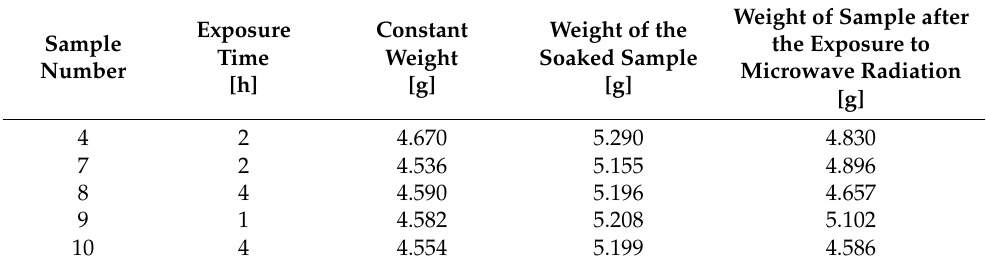
Table 3. Weight summary of each sample after drying, soaking, and exposure to one cycle of microwave radiation.